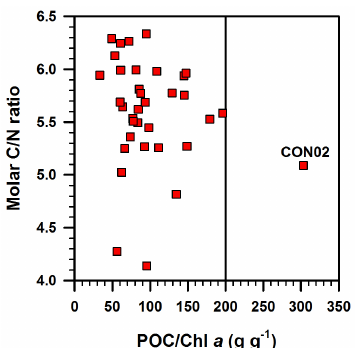
Figure 9. Molar C / N ratio vs. POC / Chl a ratio in suspended particulates investigated in this study. The vertical line represents POC / Chl a ratio of 200gg − 1 , the upper limit for phytoplankton- dominated particulate organic matter (Savoye et al., 2003). See text for more details. CON02 is the station where red tide was observed during the sampling time and the colour of the surface water was brown and dissolved oxygen in the bottom water was 1.6mgL − 1